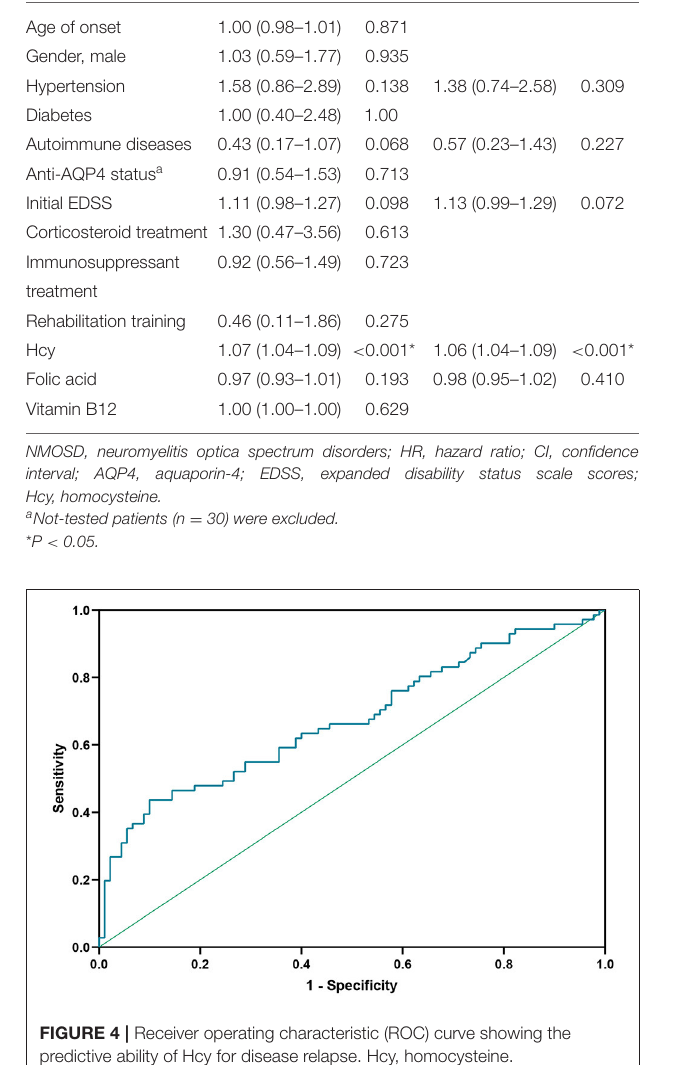
The optimal cut-off value of Hcy level for predicting relapse was 14.525 µ